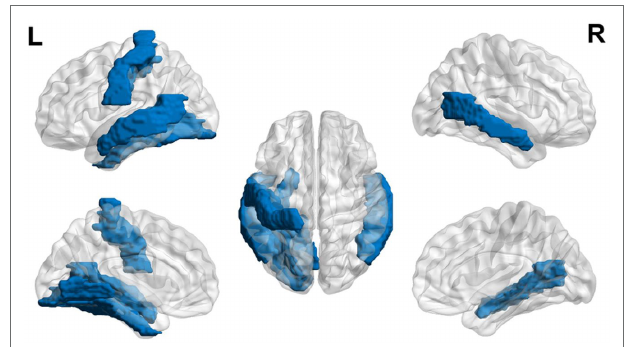
FIGURE 1 | Neural circuit dysfunction related to reading circuits in infants at risk (ages 3–5) with dyslexia. Decreased activation in bilateral middle temporal gyrus, left lingual gyrus, left postcentral gyrus, and left fusiform gyrus (Raschle et al., 2012) related to EF in children ages 3–5 at risk for dyslexia. The blue color represents decreased activation. Data are presented in sagittal and axial views in the left and right hemispheres (L = left and R = right) over a glass brain. Regions were defined based on Automated Anatomical Labeling (AAL) atlas (Tzourio-Mazoyer et al., 2002). Image created using the BrainNet Viewer (Xia et al.,